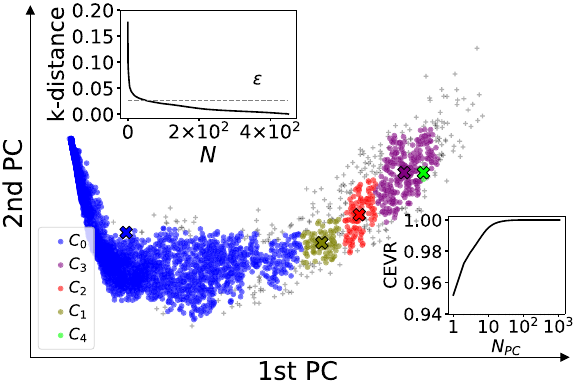
Fig. 4 Representation of the structures visited by the evolu- tionary algorithm. Results showed for pristine bulk silicon crystal. Scatter plot of the fi rst two principal components of crystal fi ngerprint descriptors for the structures generated during the EA run (see main text for the details). Cluster centroids are shown with crosses. The inset at the top-left corner shows the k -distance plot used to fi nd the clustering parameter ε . The inset at the bottom- right corner shows the cumulative explained variance ratio (CEVR) as a function of the number of principal components ( N PC ). Cluster names are given according to their distance from the left-most cluster and they are ordered in the legend according to their